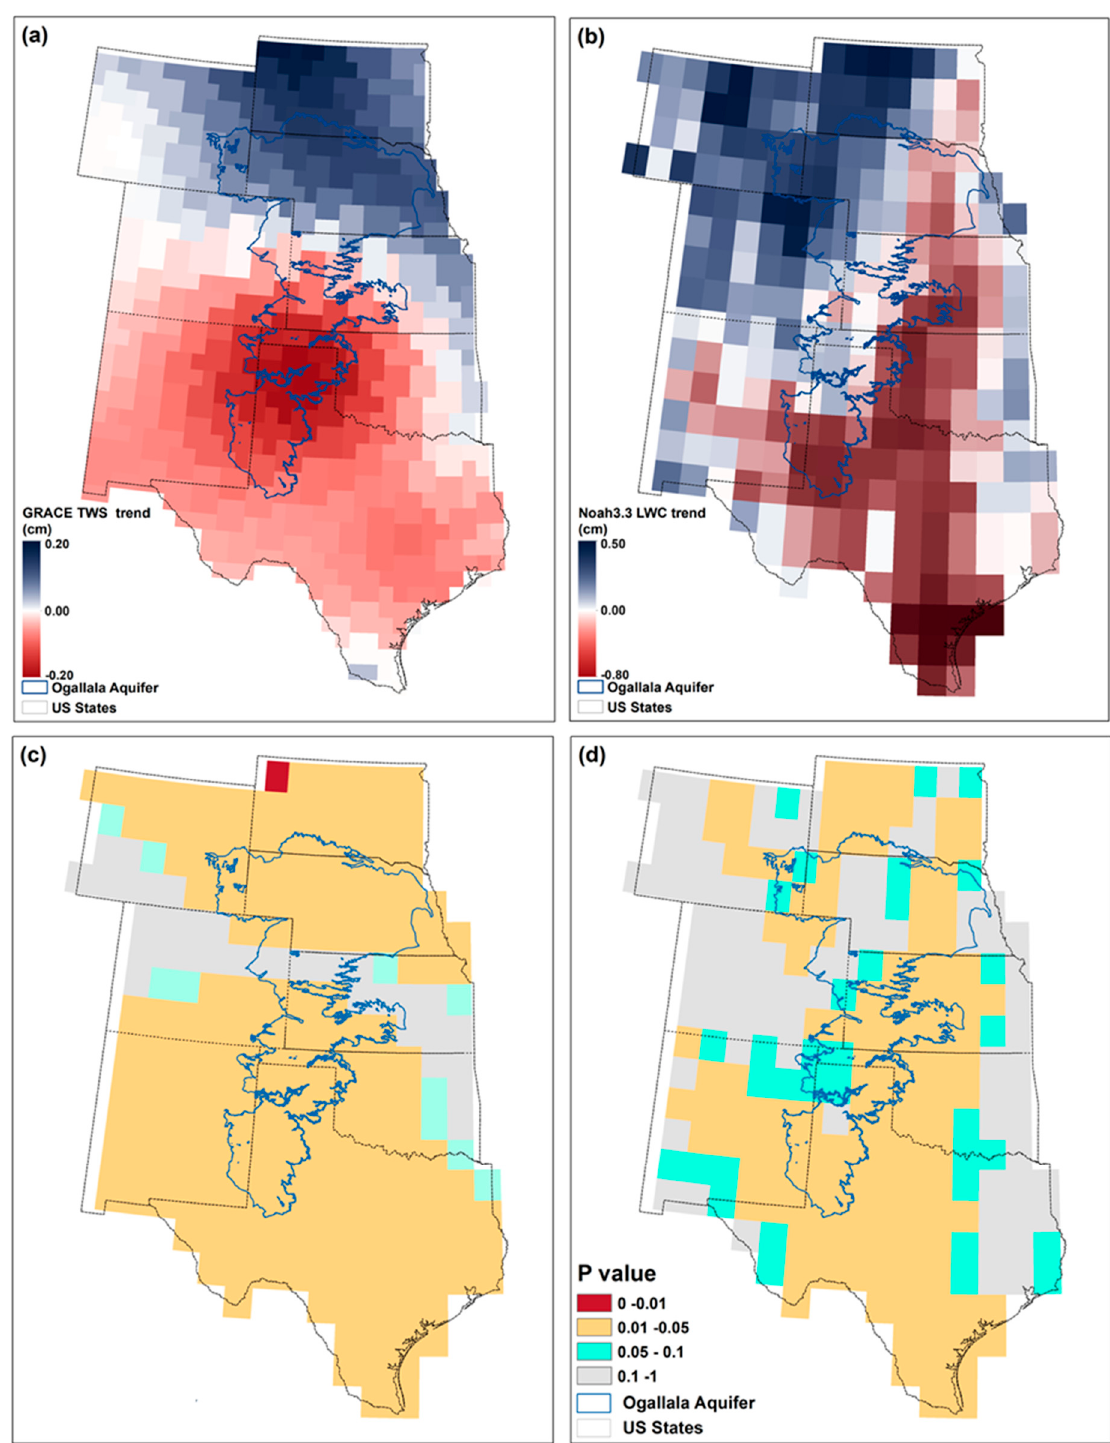
Figure 8. TWS ( a ) and LWC ( b ) trends for the period 2002 to 2017. p values for TWS ( c ) and LWC ( d ) indicate significance level of the trend.